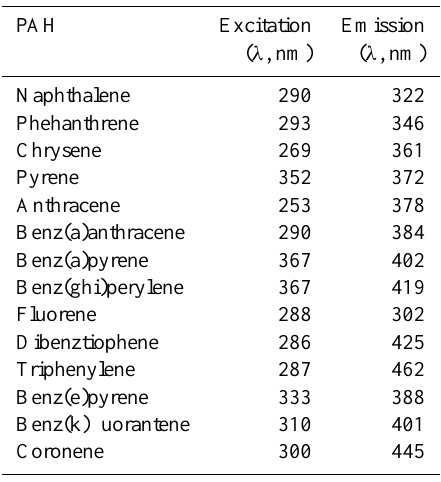
Table 1. The wavelengths of the excitation and emissions of lumi- nescence used for the PAH identifications.